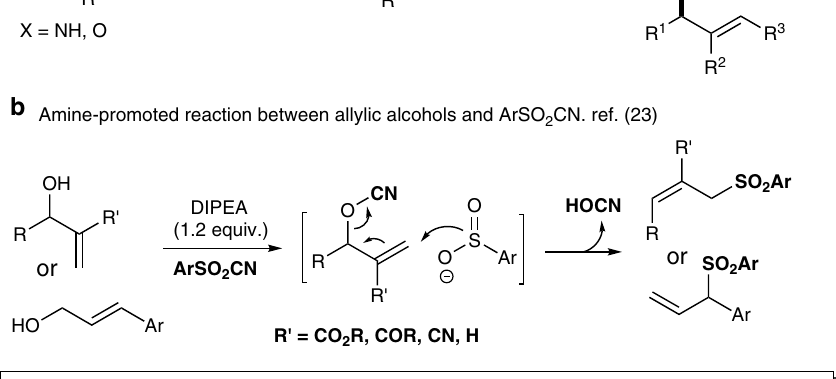
benzenesul fi nate, which means the reaction worked not as a